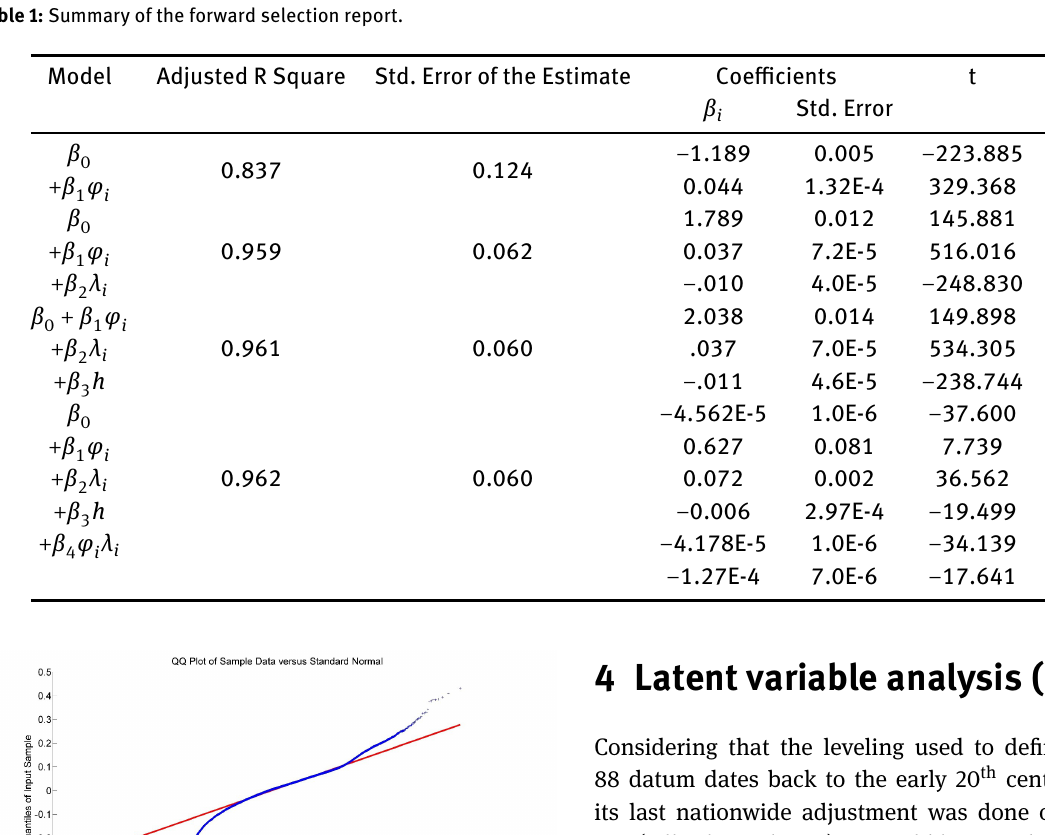
Table 1: Summary of the forward selection report.